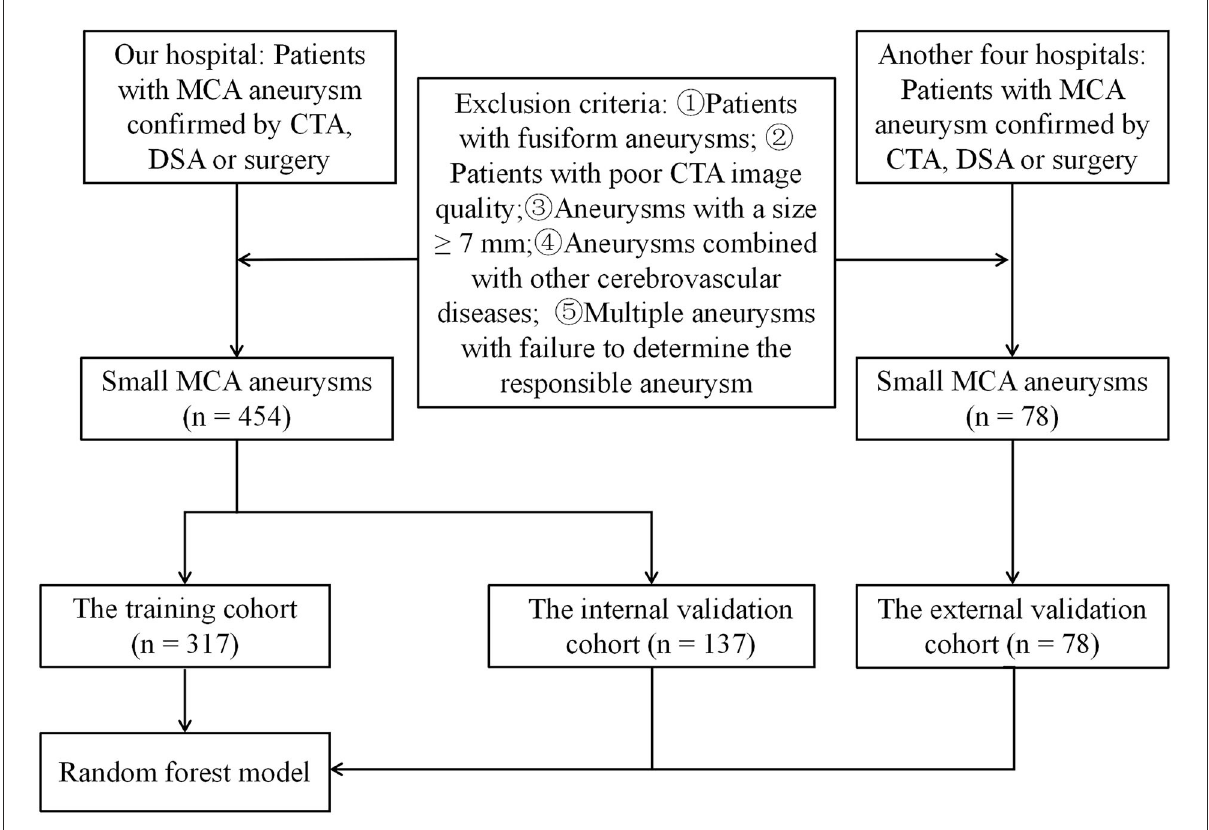
FIGURE1 The flowchart of this